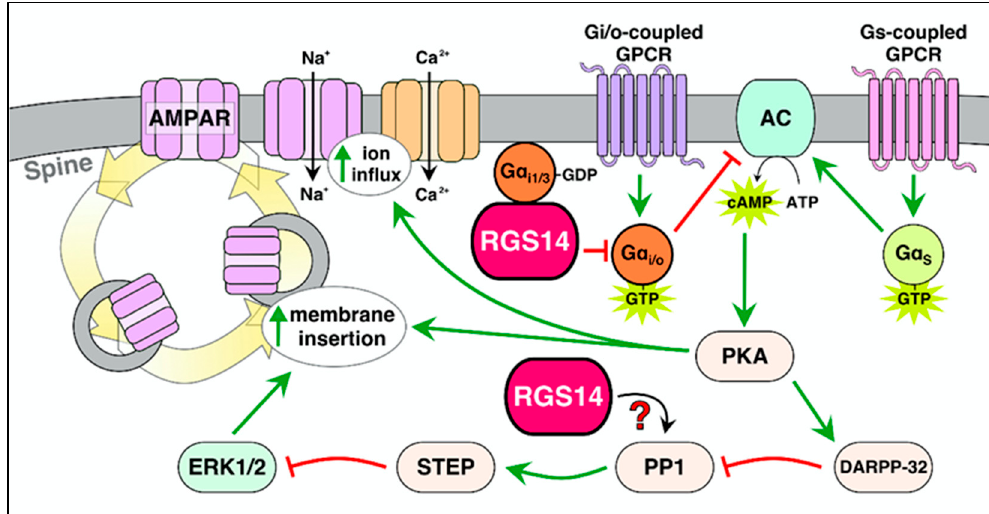
Figure 3. RGS14 modulation of G-protein-dependent signaling. RGS14 accelerates G α i/o deactivation to limit GPCR–Gi/o signaling and disinhibit the adenylyl cyclase activity and downsteram cAMP signaling. Binding of inactive G α i1/3–GDP localizes and anchors RGS14 to the plasma membrane, where it is optimally positioned to regulate the initial steps of intracellular post synaptic signal transduction. Likewise, it is possible that RGS14 modulation of GPCR signaling influences plastic processes such as AMPAR trafficking.